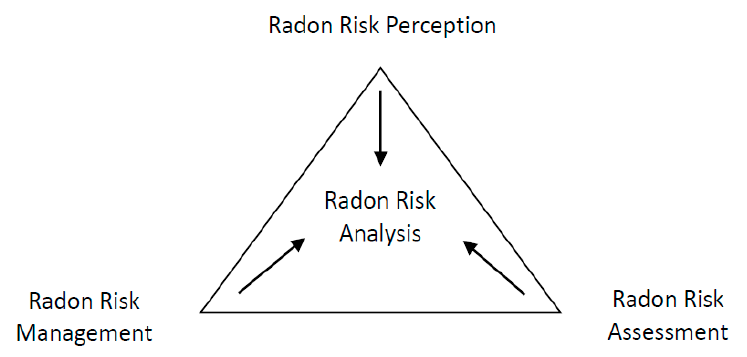
Figure 1. Radon risk analysis.